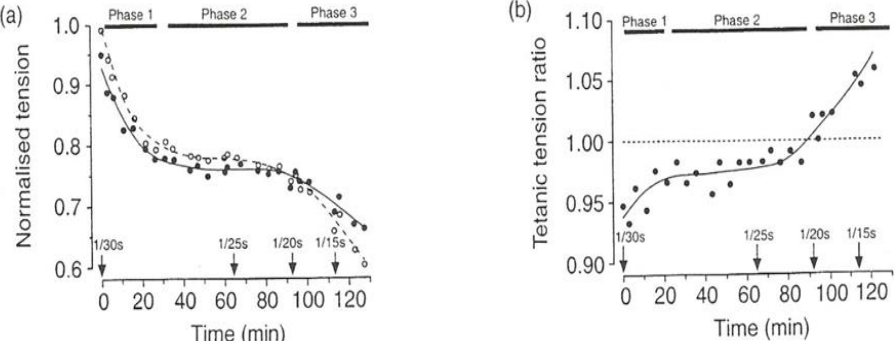
Figure 14. Data from one fibre showing fatigue-induced tension decline: horizontal bars (on top) indicate the phases of fatigue, as in Lannergren and Westerblad, (1991, [19]). ( a ) Open symbols are at atmospheric pressure and solid symbols are at high pressure (10 MPa). ( b ) Same data plotted as a high/atmospheric pressure tension ratio: note that tetanic tension is depressed by high pressure in phases 1 and 2 but potentiated at phase 3.